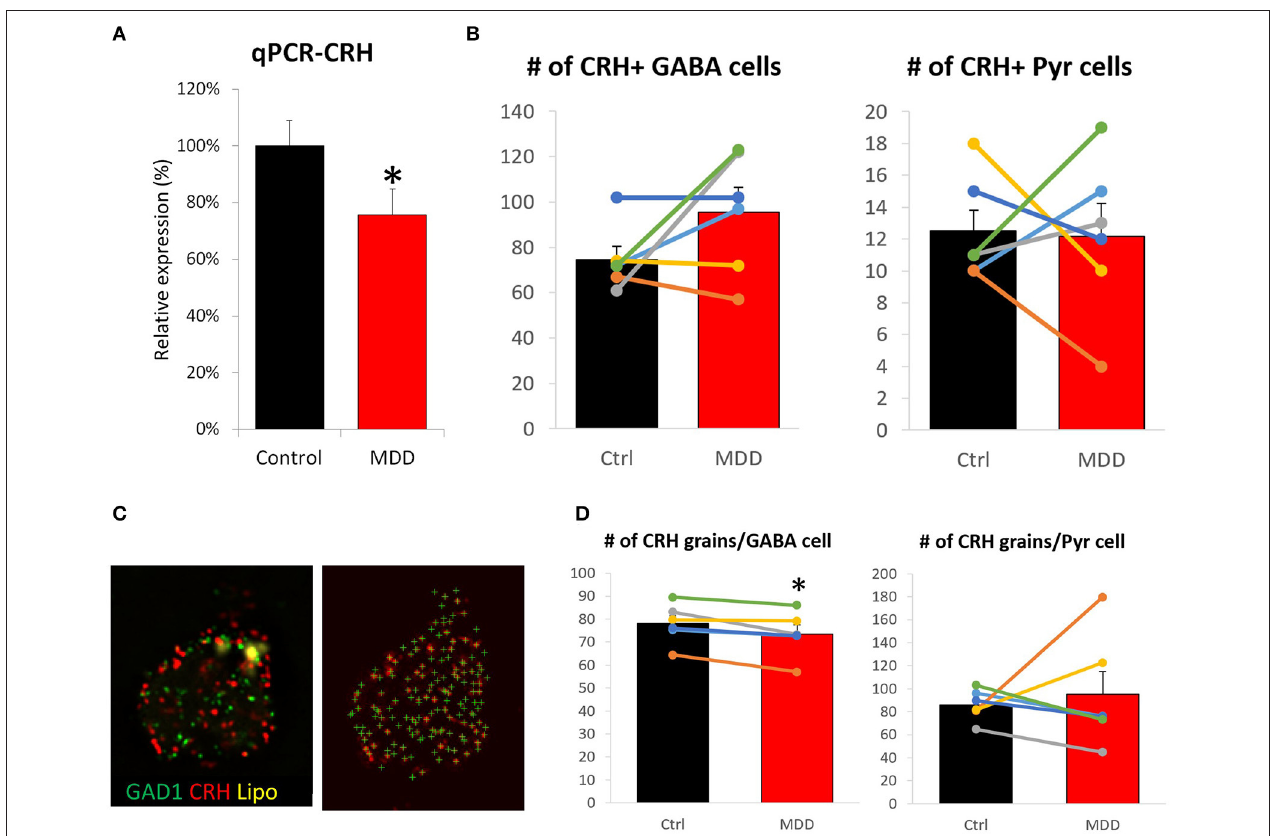
FIGURE 2 | Differences in CRH level and cell density in the sgACC of MDD subjects. (A) CRH expression level is significantly reduced in the sgACC of MDD patients compared to control. (B) There was no group difference in CRH + neuron density. (C) Right: Image of a human sgACC tissue section labeled for GAD1 (green), CRH (red). Autofluorescent lipofuscin shown in yellow. Left: Single channel image showing CRH grains detected by FISHquant. (D) Cellular CRH expression is reduced in GABAergic interneurons, but not in pyramidal neurons in the sgACC ( n = 6/group; # p < 0.1; * p < 0.05). NR3C2: LFC = 0.61 ± 0.29, FDR = 0.46]. Additionally,